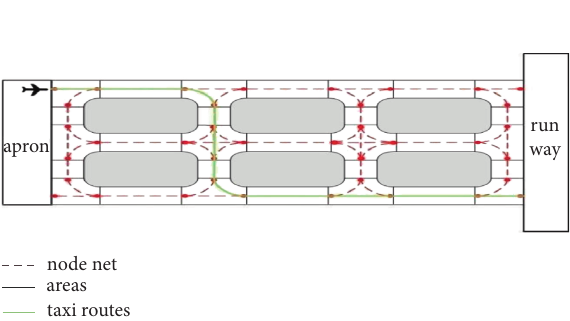
Figure 5: Schematic diagram of the taxiway node network, area division, and taxi path.